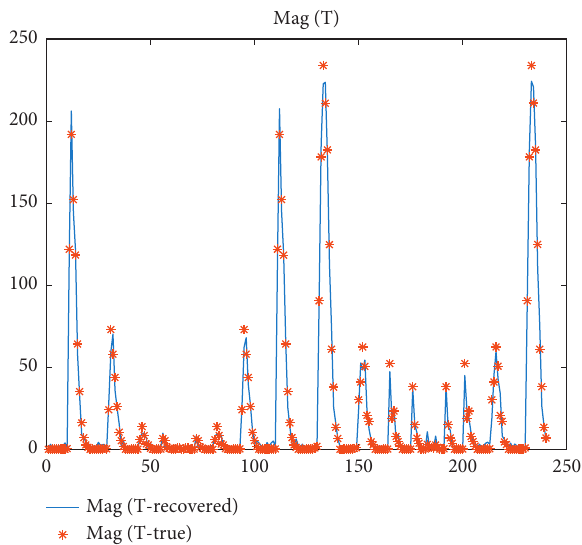
Figure 14: The magnitude distribution of the recovered SMC by using the proposed algorithm.